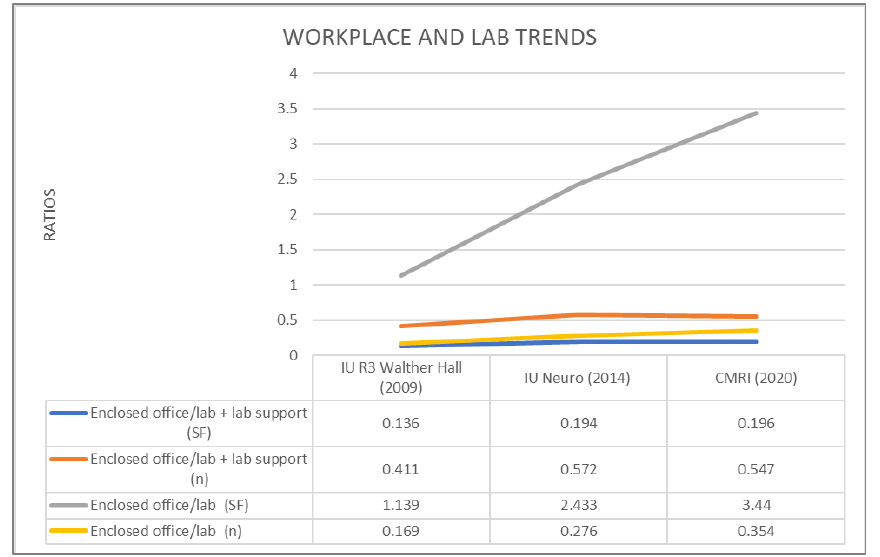
Figure 8 Workplace and lab trends and ratios across time.